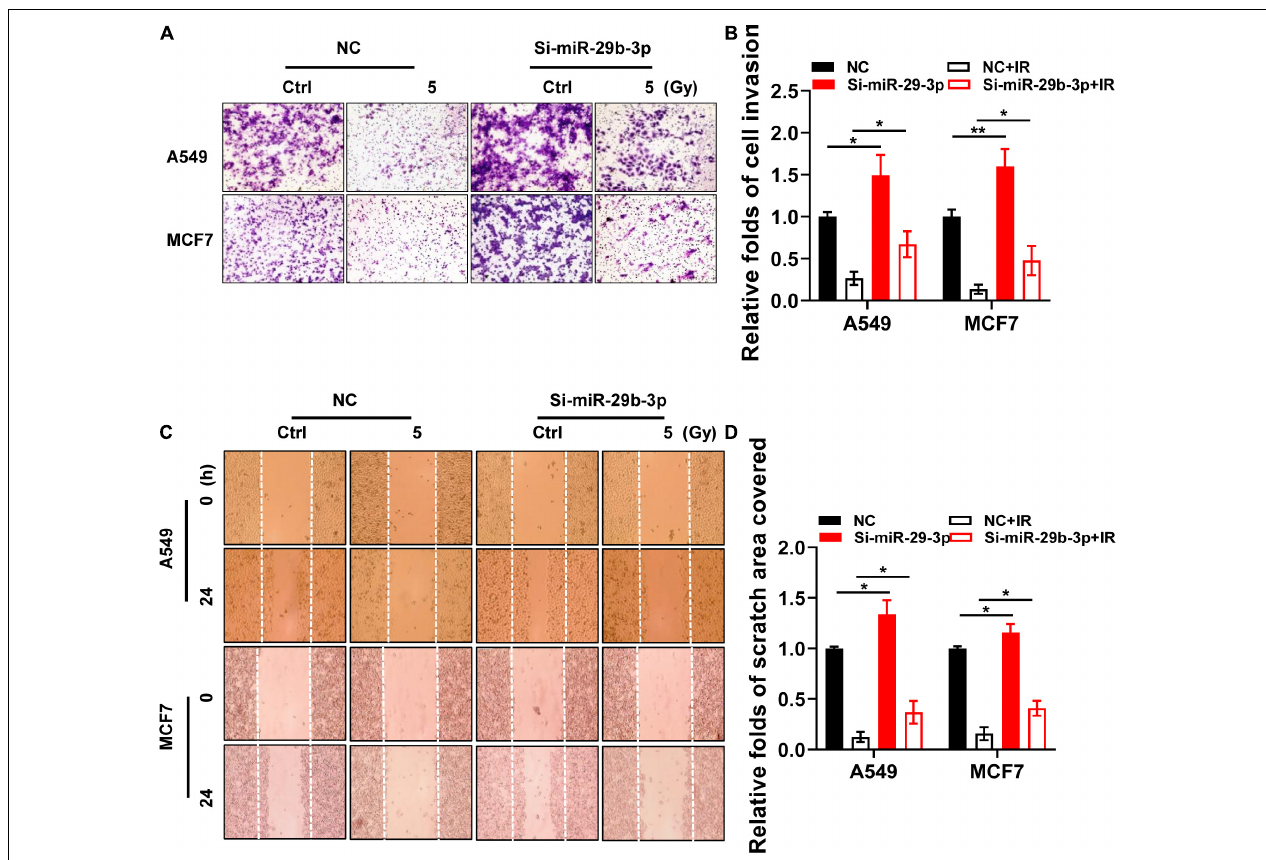
FIGURE 7 | Invasive and migratory capacity of irradiated nniR-29b-3p knockdown A549 and MCF7 cells. (A,B) Matrigel invasion assays in miR-29b-3p knockdown or negative control A549 and MCF7 cells after 5 Gy X-ray irradiation at 0 and 48 h. (C,D) Scratch wound healing migration assays in miR-29b-3p knockdown or negative control A549 and MCF7 cells after 5 Gy X-ray irradiation at 0 h and 24 h. Ctrl, unirradiated groups; NC, negative control. Significance was determined by unpaired t -test. * P < 0.05; ** P <